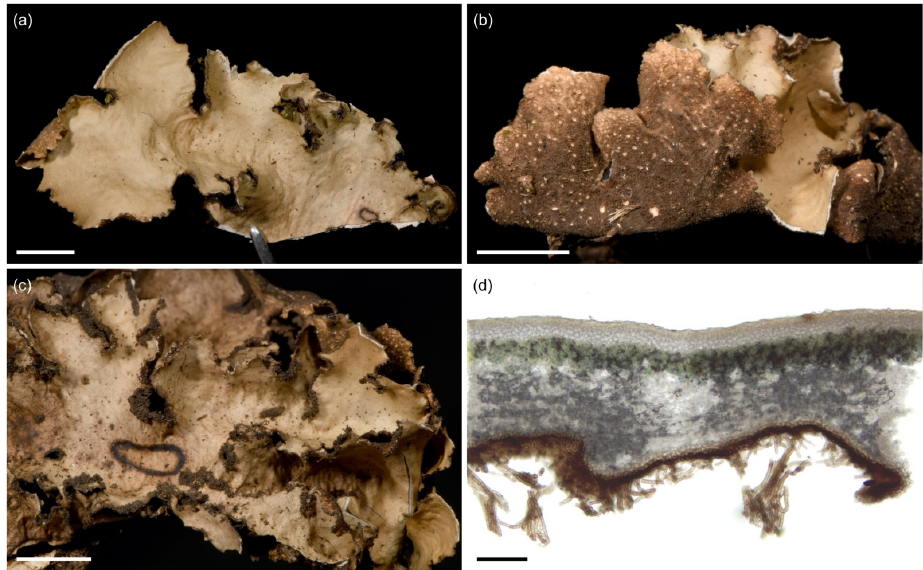
Figure 11. Sticta cyanocaperata . ( a ) A fragment of the type specimen UK171480d. ( b , c ) Additional thalli part of the same collection as the type: ( b ) Showing the brown tomentum and pale thallus margins. ( c ) Characteristic light yellowish–brown, wrinkled upper surface and dark, flattened, marginal isidia. ( d ) Thallus cross section showing the uneven lower surface (UK170912a) and the lack of moniliform secondary tomentum. Scales 0.5 cm in ( a – c ), 100 µm in ( d ).